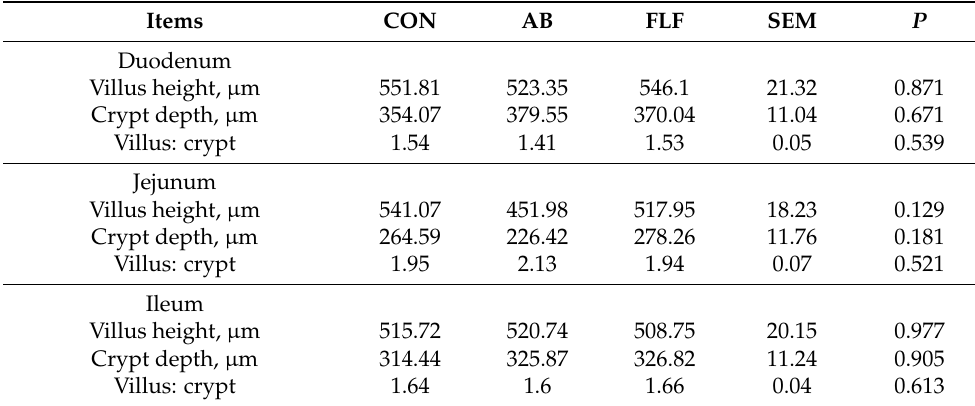
Table 7. Effects of fermented liquid feeding on intestinal morphology of